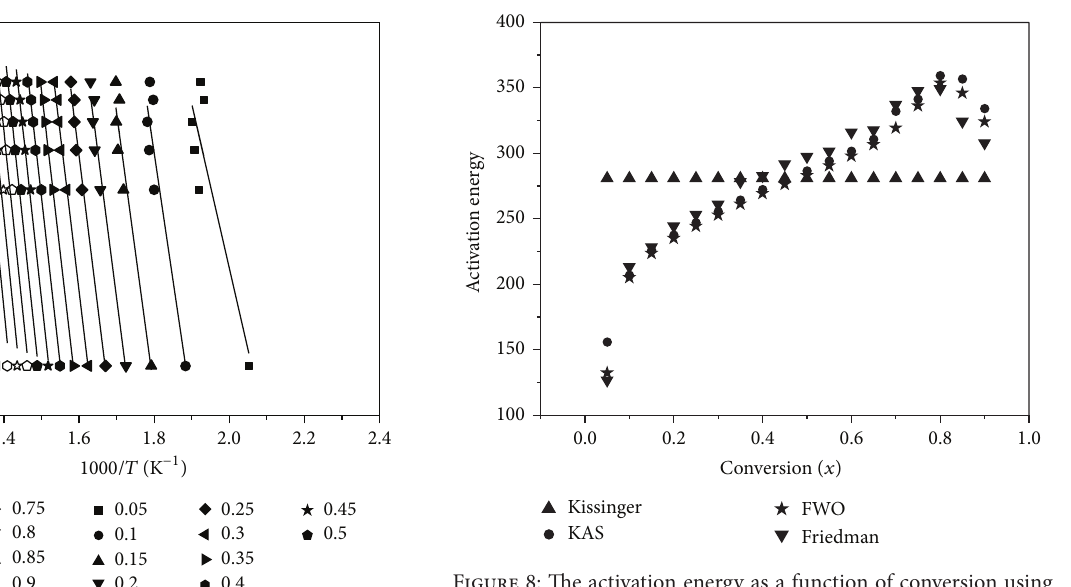
Figure 8: The activation energy as a function of conversion using model-free isoconversional